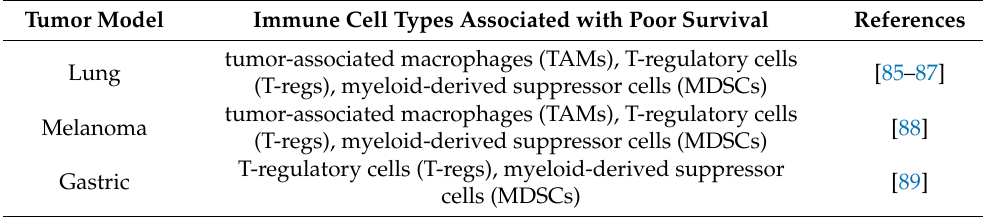
Table 1. Key tumor-associated immune cell types that contribute to an immunosuppressive TIME. Tumor